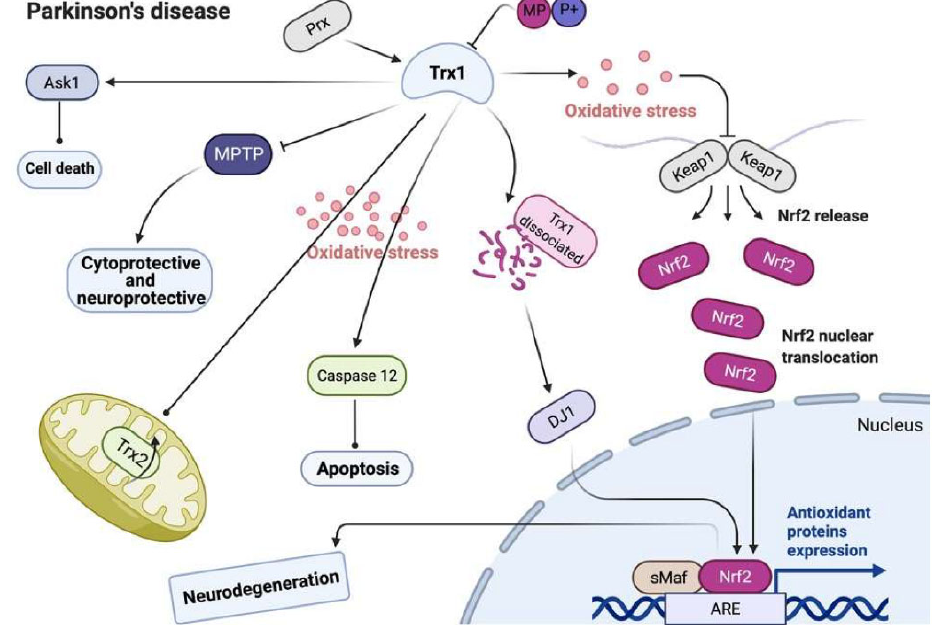
Figure 3. The involvement of Trx1 in pathophysiological signal pathways of Parkinson’s disease (PD). Trx1 participates in a variety of biological pathways of PD. During oxidative conditions, Trx1 stimulates apoptosis signaling caspase 12, which antagonizes the activity of mitochondrial complex I. Trx1 might also suppress MPTP in cytoprotective and neuroprotective mechanisms. When exposed to H 2 O 2 and dissociated from Trx1, ASK1 can co-immunoprecipitate with DJ-1. Meanwhile, DJ-1 induces expression of Trx1 via transcription factor Nrf-2 to protect cells against oxidative stress. Also, Prx has a protective role via Trx1-ASK1 against dopaminergic neuron cell death. Nrf-2: nuclear factor erythroid 2-related factor 2; MPTP: 1-methyl-4-phenyl-1,2,3,6-tetrahydropyridine; Trx: thioredoxin; TrxR: thioredoxin reductase; Prx: peroxiredoxin; ASK1: apoptosis signal-regulating kinase 1; A β : amyloid β